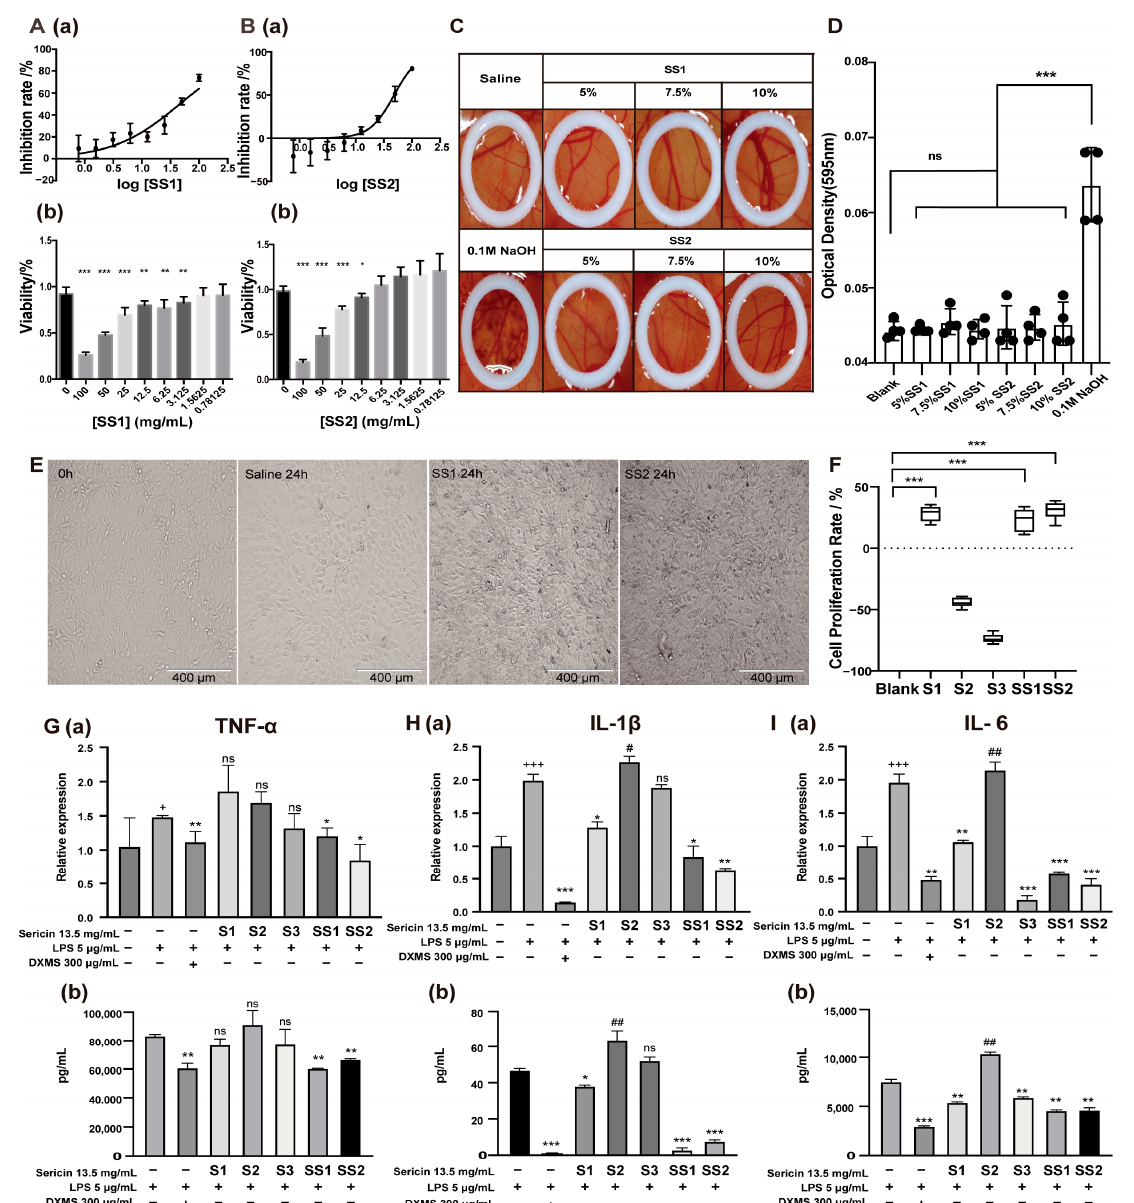
Figure 3. The multiple effects of sericin. ( A , B ) The IC 50 analysis ( a ) and the cytotoxicity ( b ) of SS1 ( A ) and SS2 ( B ). Various concentrations of samples (dilution factor: 1.41) were added to NIH 3T3 cells in the logarithmic growth phase and cell viability was measured with a CCK-8 kit; the IC 50 of these was calculated. * p < 0.05, ** p < 0.01, *** p < 0.001. n = 6. ( C , D ) Stimulation of sericin on CAM. The pictures ( C ) and OD analysis ( D ) of CAM treated with different concentrations of sericin. Sericin showed no irritation to CAM. ( E ) Cell status after treatment with SS1 and SS2 for 24 h. Both SS1 and SS2 treatments (13.5 mg/mL) increased the number of NIH 3T3 cells. ( F ) Cell proliferation rate after 13.5 mg/mL sericin samples treatment for 24 h. *** p < 0.001. n = 6. ( G – I ) Effect of sericin samples on TNF- α ( G ), IL-1 β ( H ), and IL-6 ( I ) produced by LPS-induced macrophages. The levels of inflamma- tory cytokines were measured by qRT-PCR ( a ) and ELISA ( b ). + Relative to no-treated cells, * and # relative to LPS-treated cells. +Indicated promotion, + p < 0.05, +++ p < 0.001. * Indicated suppression, * p < 0.05, ** p < 0.01, *** p < 0.001. # Indicated promotion, ## p < 0.01. n = 3.